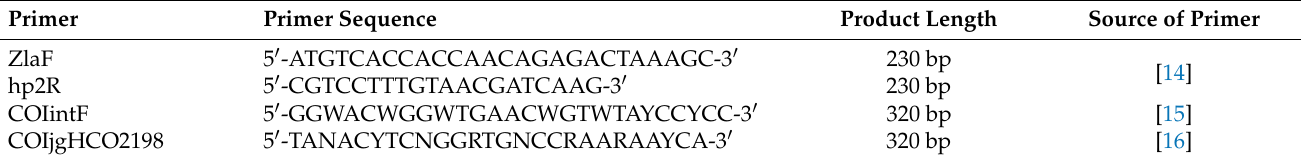
Table 1. Sequences of primers used in this study.